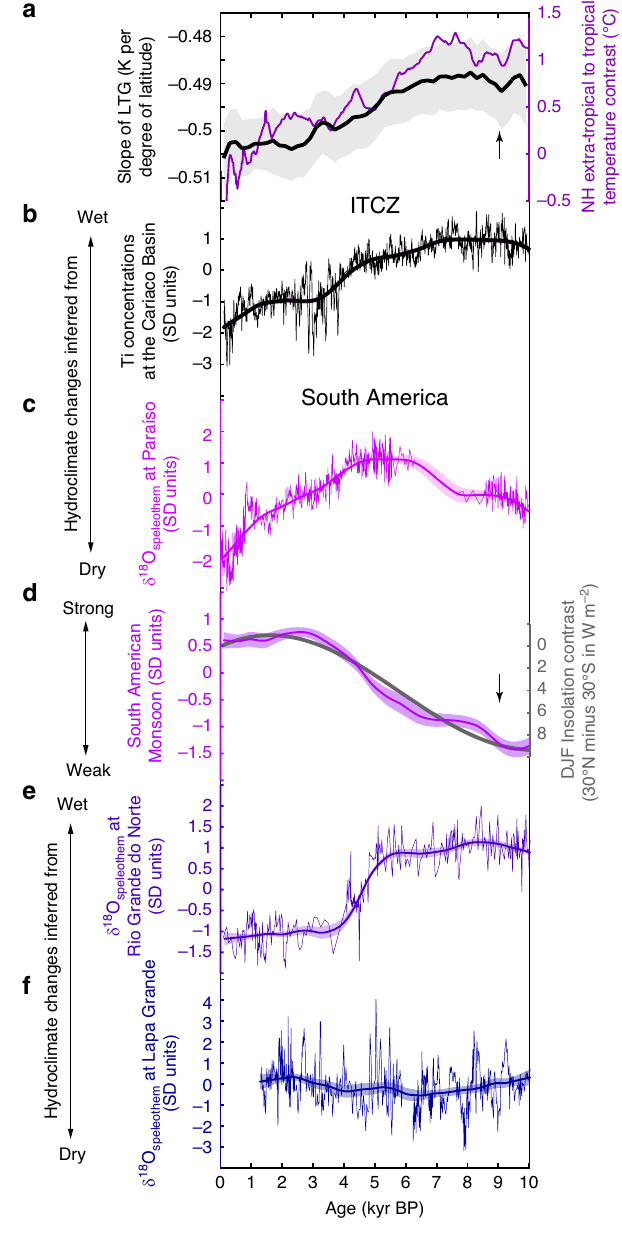
(December – March) interhemispheric insolation contrast decreases and the latitudinal temperature gradient between the low-latitudes and the high-latitudes in the Northern Hemisphere strengthens,